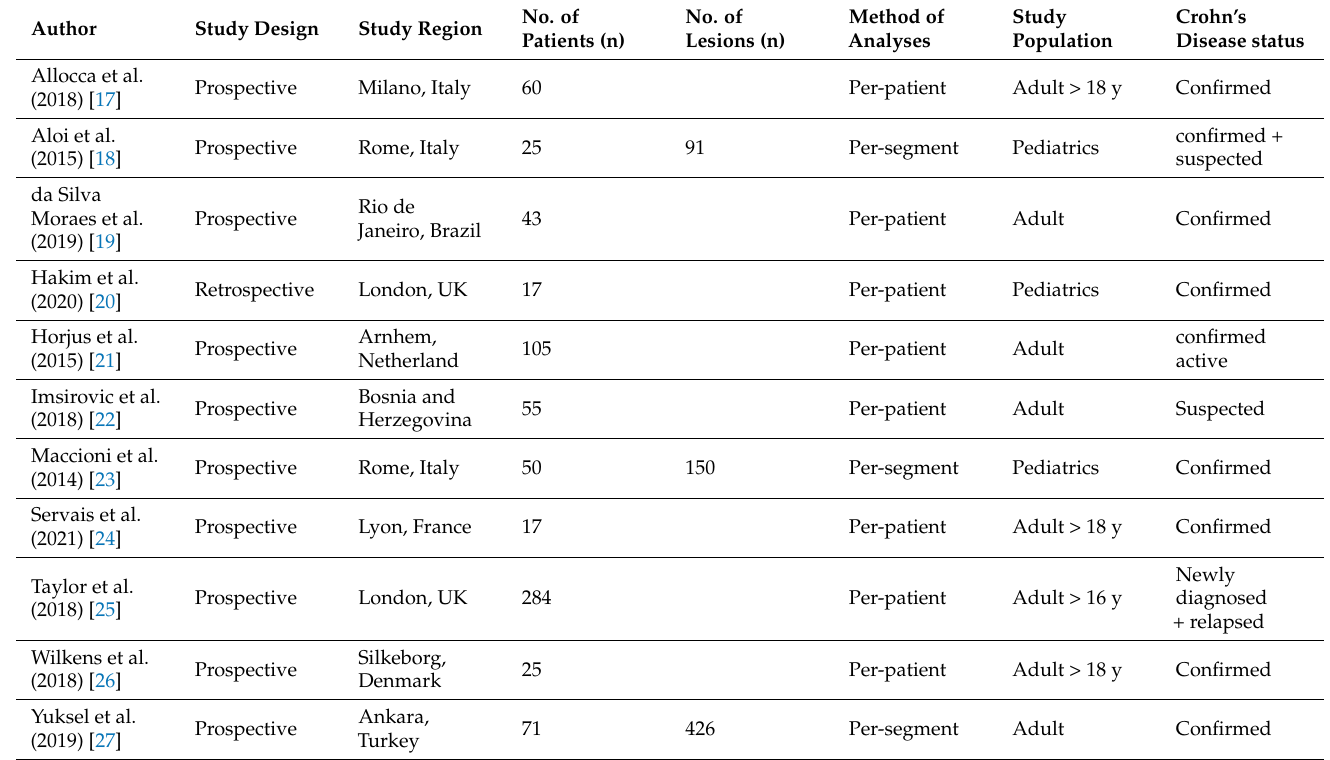
Table 1. Study characteristics of patients.